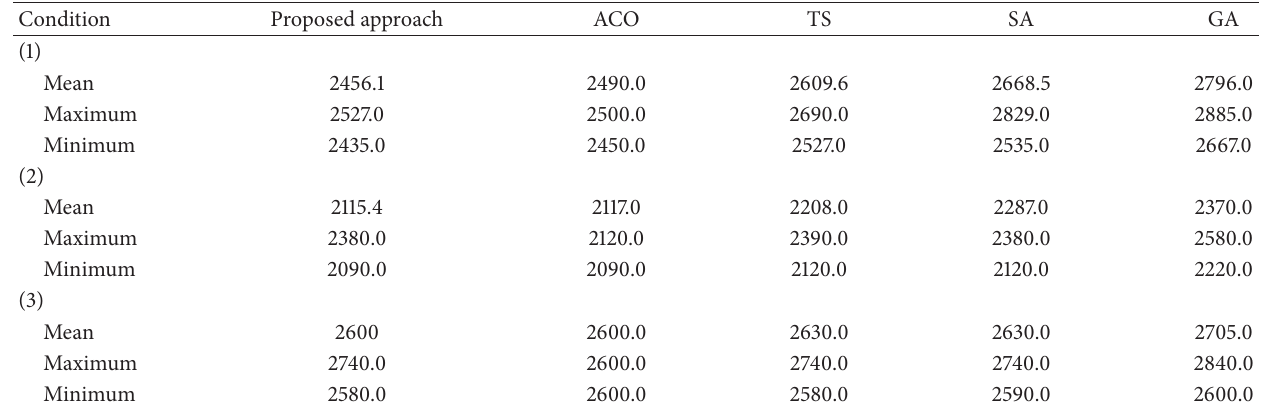
Table 12: Results compared to other algorithms for the sample part in Figure